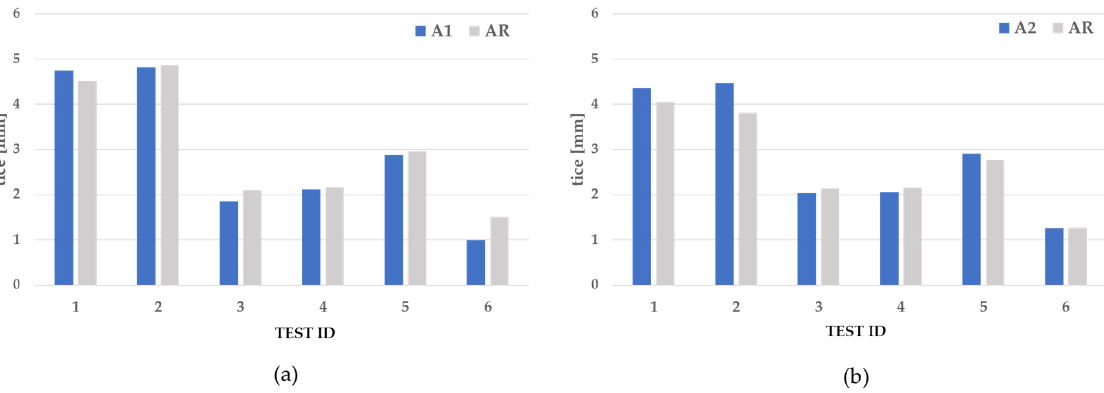
Figure 13. Schematic drawing of the accreted ice shape. With an angle of attack equal to zero, A represents the stagnation point ( a ). Measurement of the samples’ chord length after each test ( b , c ).